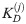
Binding modes for a 2-Ab mixture.Two antibodies with concentrations c1 and c2 can bind (A) independently to different epitopes or (B) competitively to the same epitope. (C) Antibodies bind synergistically if either the product of binding affinities (KD(j)) or potencies (αj) are altered when both antibodies bind.